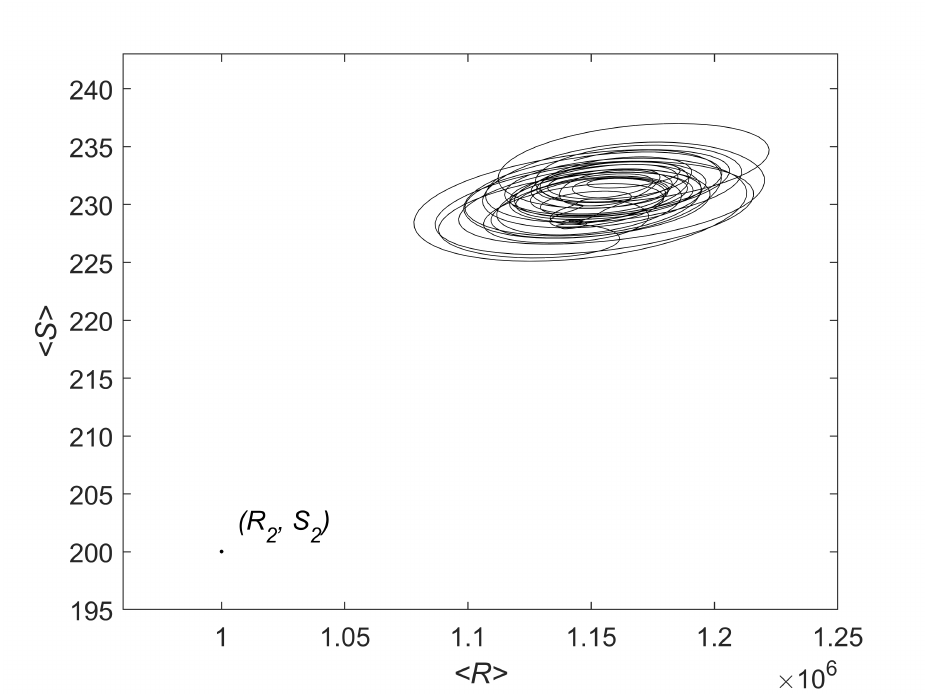
Figure 3. Phase trajectory of model (1)–(6), (15) in the plane of spatially averaged values ( (cid:104) R (cid:105) , (cid:104) S (cid:105) ) . Parameters are given in Table 4. Point ( R 2 , S 2 ) depicts the unstable stationary homogeneous state.